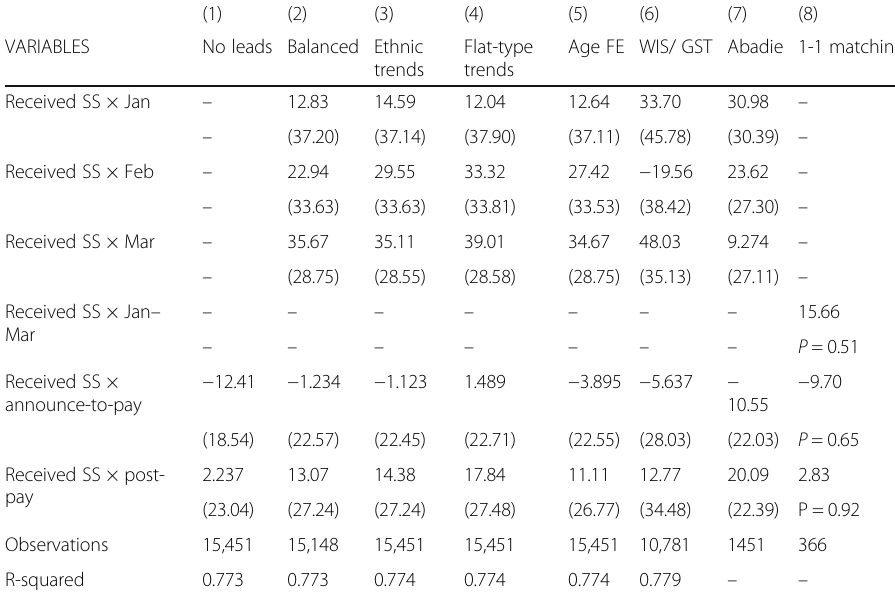
Table 18 Robustness check for impact of receiving SSS payouts on amount of private cash